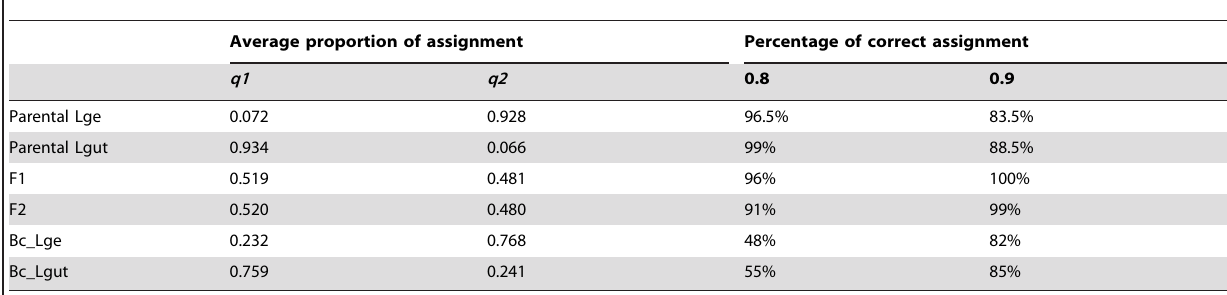
Table 2. Results of the Bayesian analysis performed with STRUCTURE on the simulated